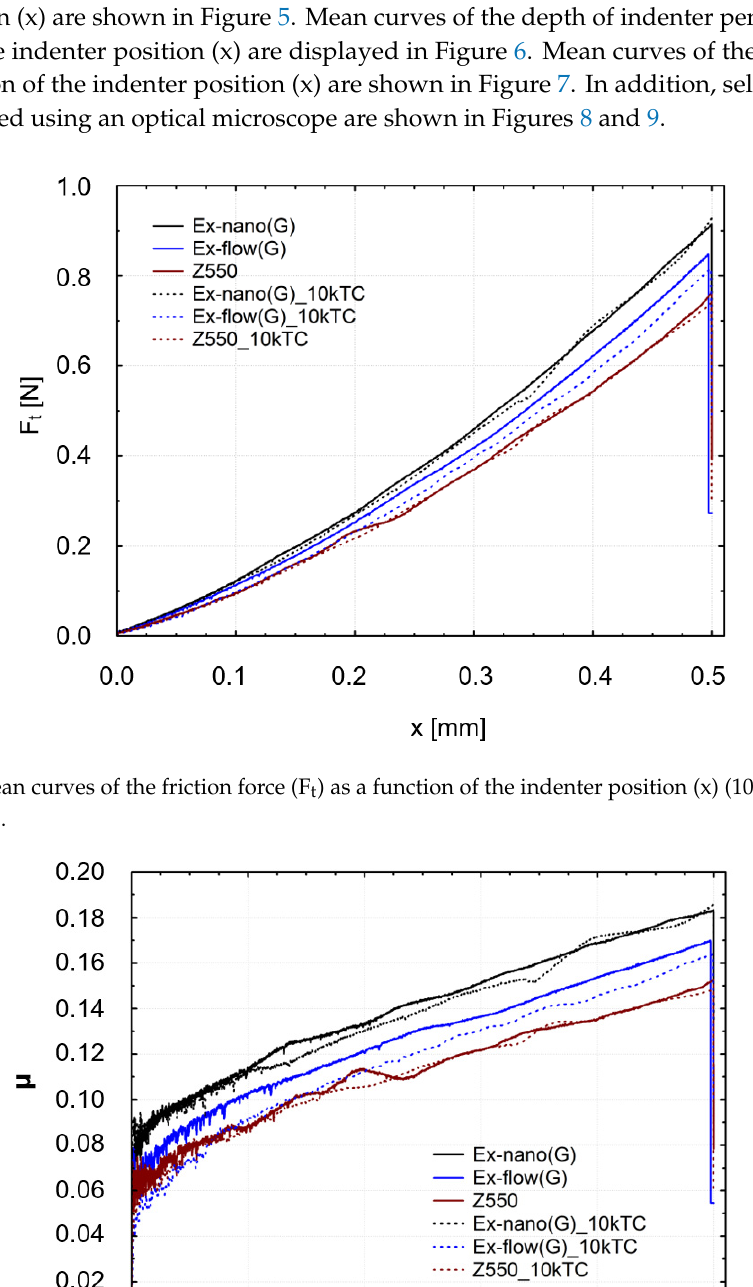
Figure 6. Mean curves of the indenter penetration depth (P d ) as a function of the indenter position (x).